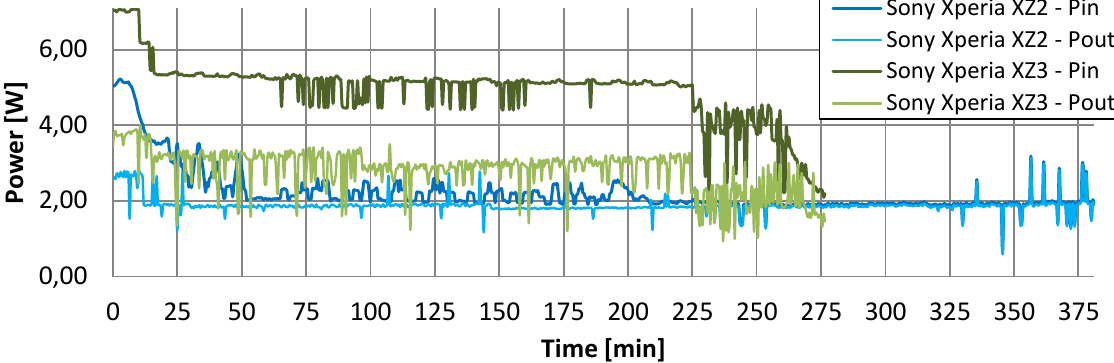
Fig. 3. Characteristics of input and output power for standard charging for selected smartphone